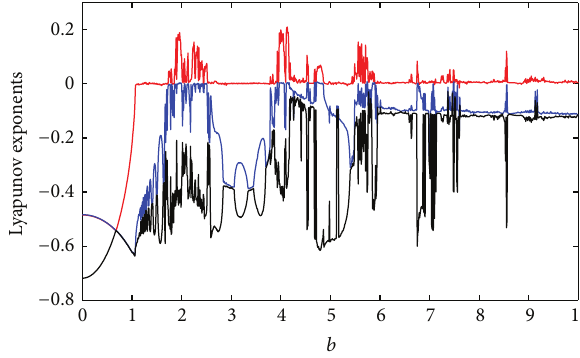
Figure 9: Lyapunov exponents about 𝑏 .